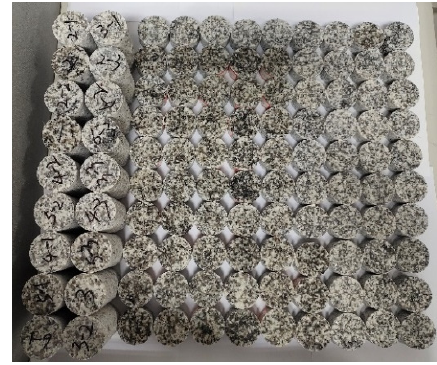
Figure 1. Specimens photograph.